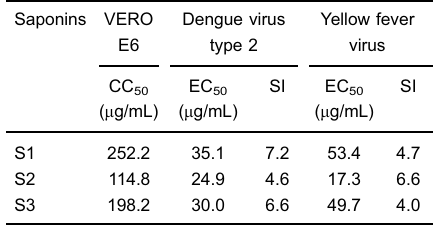
Table 1. Virucidal activity of the saponins isolated from the roots of S. sisymbriifolium . Saponins VERO Dengue virus E6 type